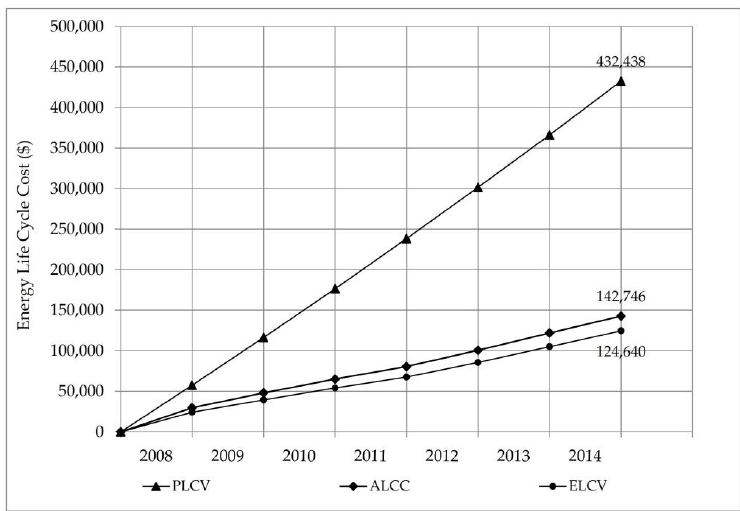
Figure 5. Energy cost performance measurement parameters.